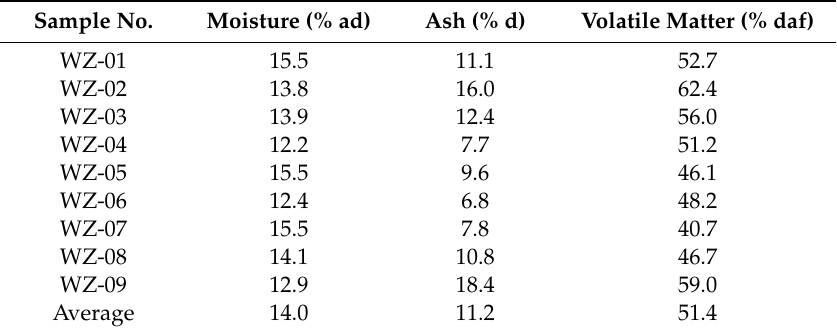
Table 1. Proximate analysis of the coal samples (wt. %); ad, air dried; d, dry basis; daf, dry ash free. Sample No.